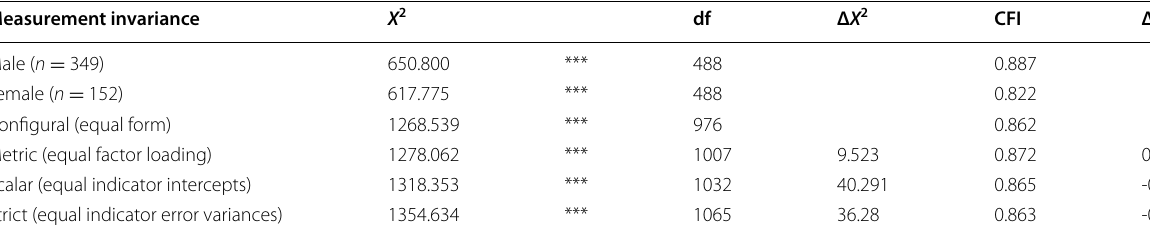
Table 6 Test of measurement invariance of PMCSQ-2BR on male and female